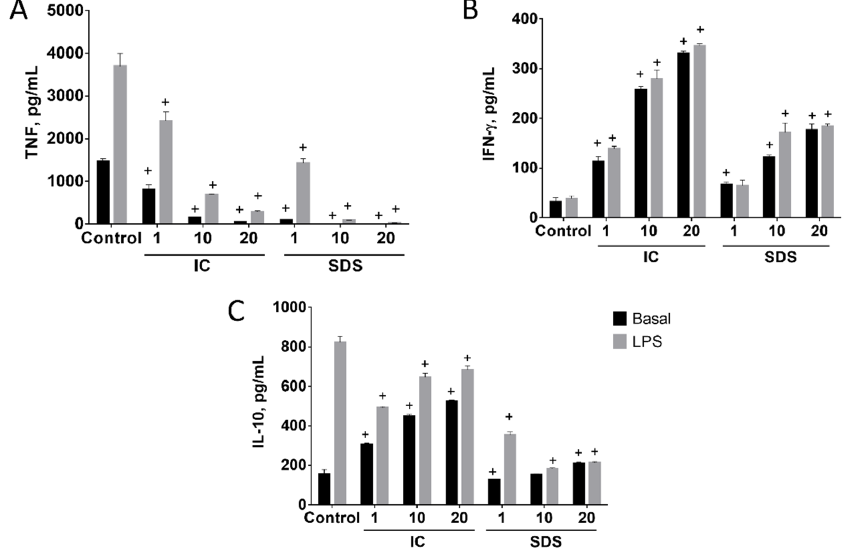
Figure 2. Effects of immunoglobulin concentrate (IC) and spray dried serum (SDS) on the production of TNF ( A ), IFN- γ ( B ), and IL-10 ( C ) in basal and LPS-stimulated rat splenocytes. IC and SDS (1, 10, and 20 mg/mL) were added to the cell culture medium and cytokines were measured in the supernatant after 24 h by ELISA. LPS (1 µ g/mL) was added to stimulate cells 2 h after IC/SDS. Data are represented as mean ± SEM and are representative of two independent experiments ( n = 6). + p < 0.05 vs. Control